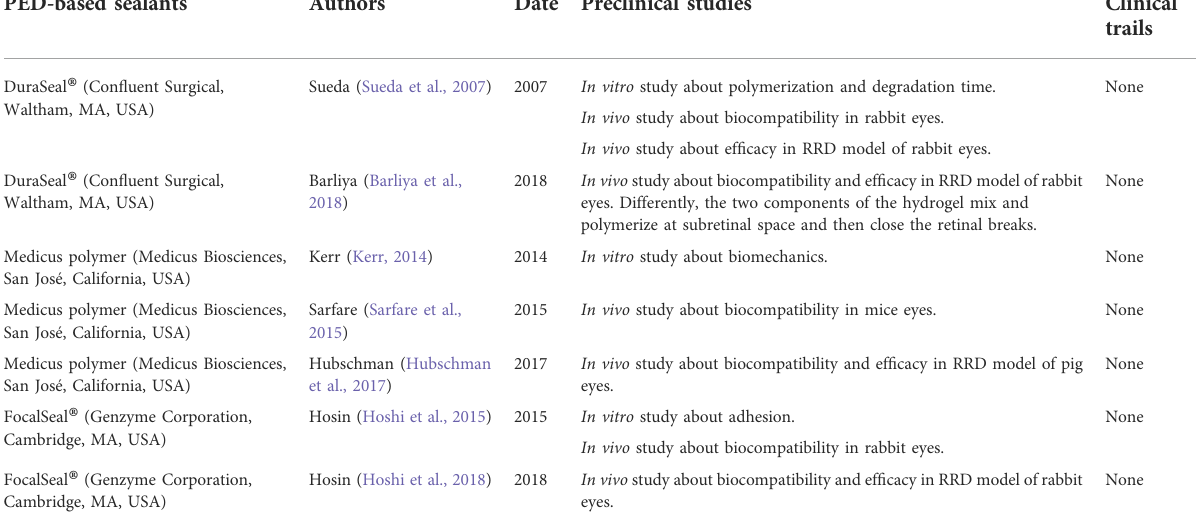
TABLE 4 The summaries of studies about PEG-based sealants as a retinal patch for the treatment of RRD. PED-based sealants